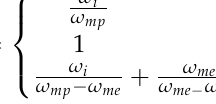
Figure 13. The distance factor variation relationship in Equation (4). Figure 14. The distance factor variation relationship in Equation (5). 2.5. Sharpness Evaluation Model After acquiring distance factors, the final sharpness evaluation value can be obtained by introducing them into Equation (6). Value = (cid:3533) 𝑑 ( 𝜔 (cid:3036) ) (cid:3104) (cid:3288)(cid:3276)(cid:3299)(cid:3254) (cid:3104) (cid:3288)(cid:3284)(cid:3289)(cid:3254)